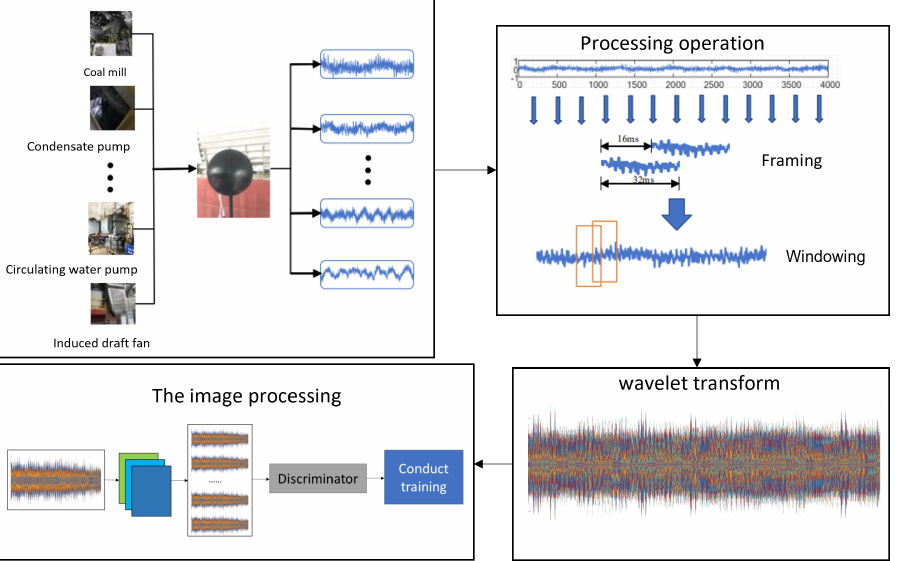
Figure 1. The overall idea of the experimental process. The figure includes the power equipment sound-field-acquisition module, the sound signal preprocessing module, the wavelet transform output image module and the image-processing